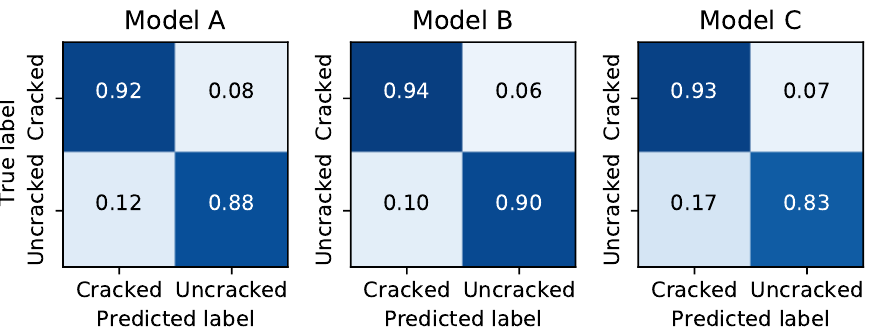
Figure 6. Confusion matrices for each architecture when tested on lab images not included in the training